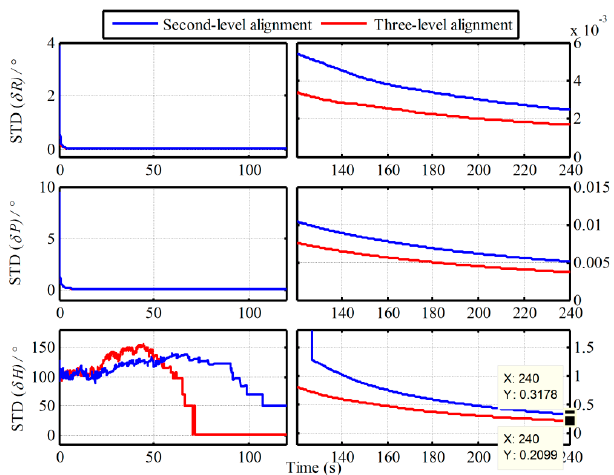
Figure 8. STD curves of alignment results with the proposed algorithm.